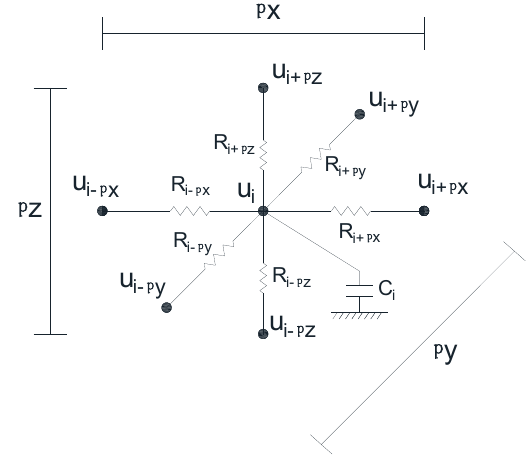
Figure 4. Network model of the element cell (3D rectangular consolidation).